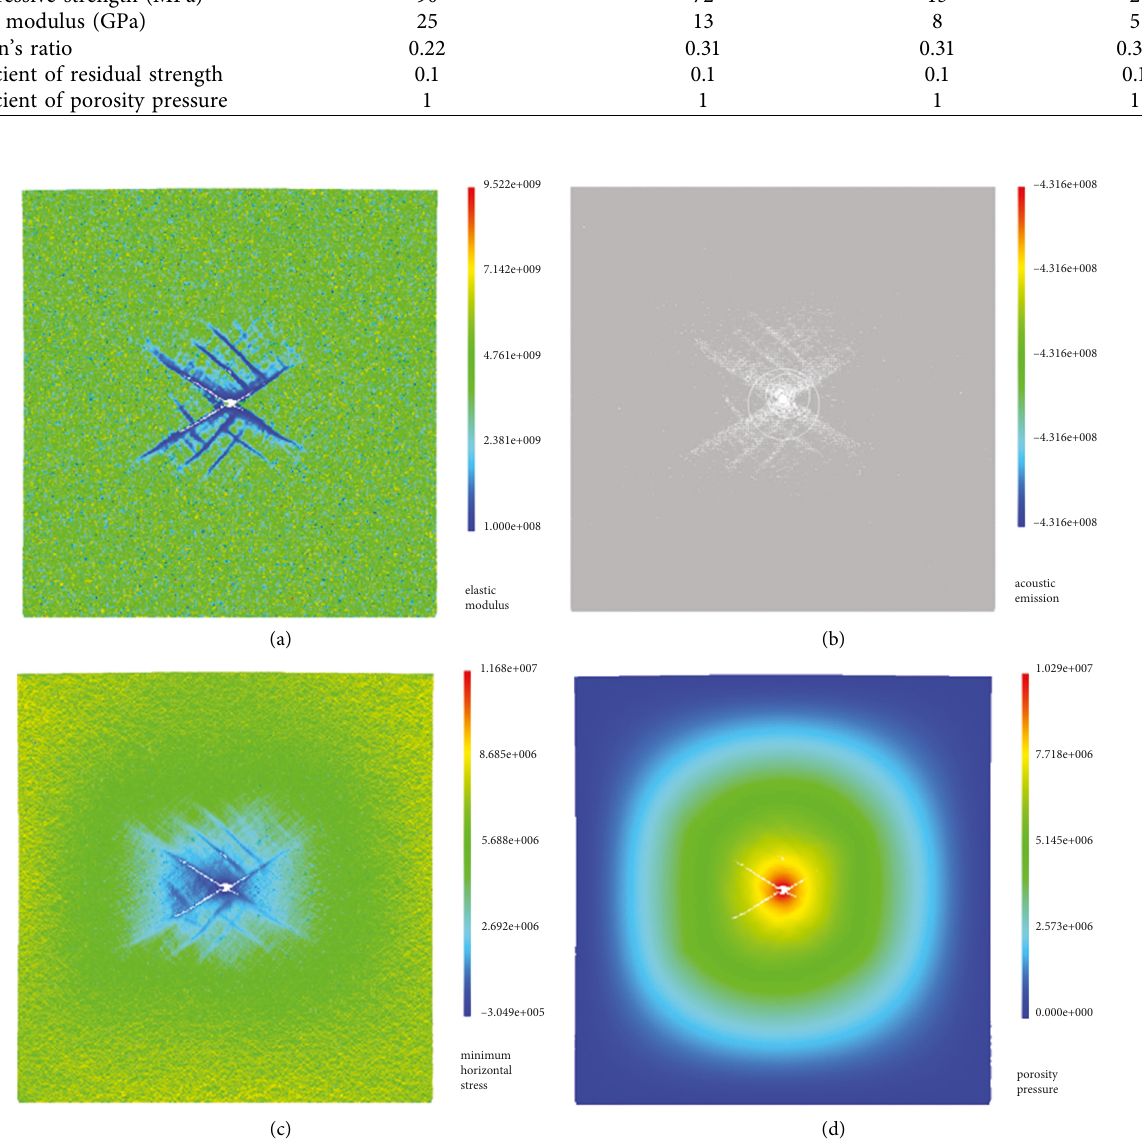
Figure 5: Fracture morphology of soft coal fracturing. (a) Elastic modulus. (b) Acoustic emission. (c) Minimum horizontal stress. (d) Porosity pressure.